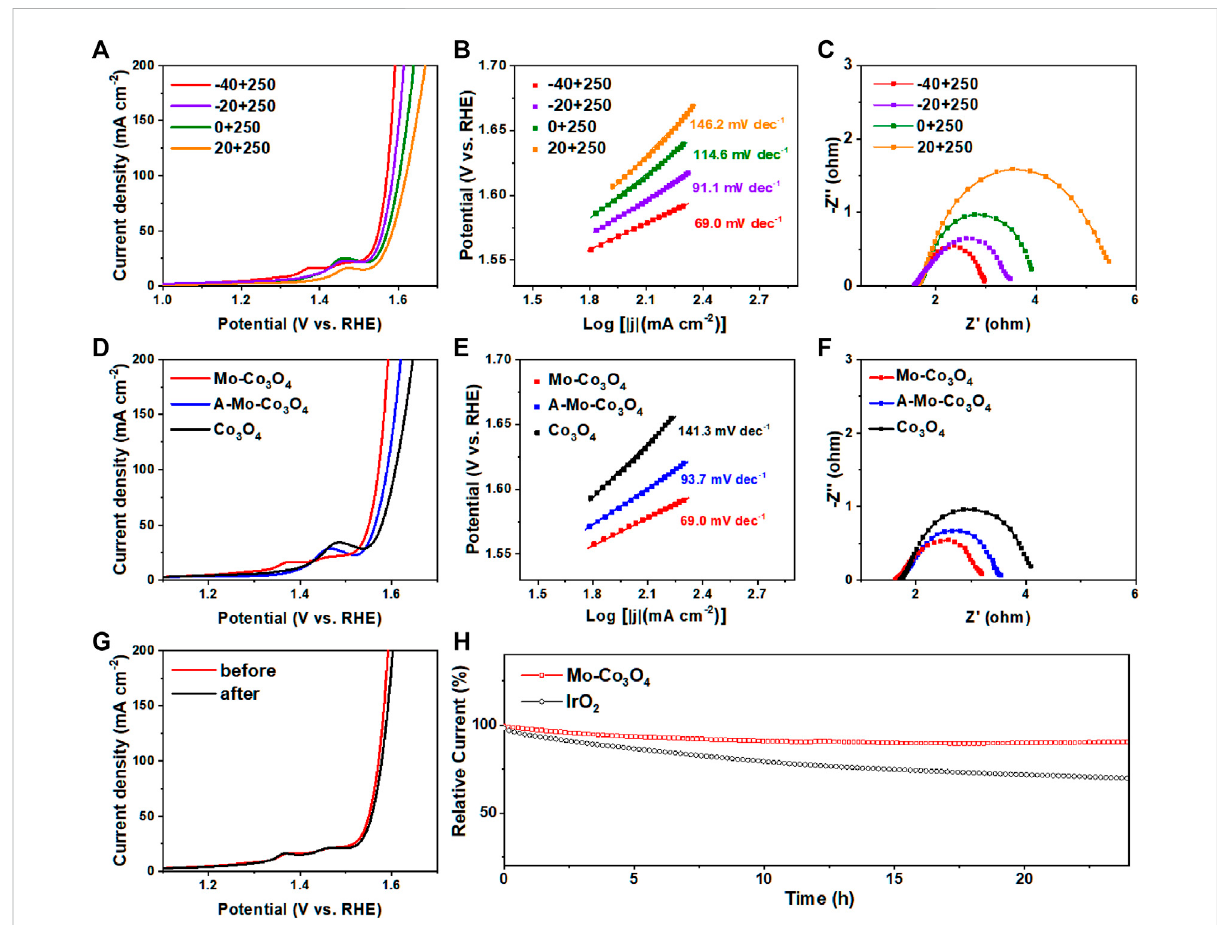
FIGURE 5 (A) LSV curves, (B) Tafel plots and (C) Nyquist plots obtained from EIS measurements at 1.6 V (vs. RHE) of Mo-Co 3 O 4 electrodes with different cooling temperatures ( − 40 ° C, -20 ° C, 0 ° C and 20 ° C), all were heated under 250 ° C. (D) LSV curves, (E) Tafel plots and (F) Nyquist plots were obtained fromEISmeasurementsat1.6 V(vs.RHE)ofMo-Co 3 O 4 electrodeswithdifferentannealingtemperatures(Mo-Co 3 O 4 ,A-Mo-Co 3 O 4 andCo 3 O 4 heat treatment only). (G) Stability tests by ADT method for Mo-Co 3 O 4 (heated under 250 ° C and quenched under -40 ° C), where polarization curves arerecordedbefore and after 5000CVcycles. (H) Chronoamperometrycurves of Mo-Co 3 O 4 (heated under 250 ° C and quenched under − 40 ° C) and commercial